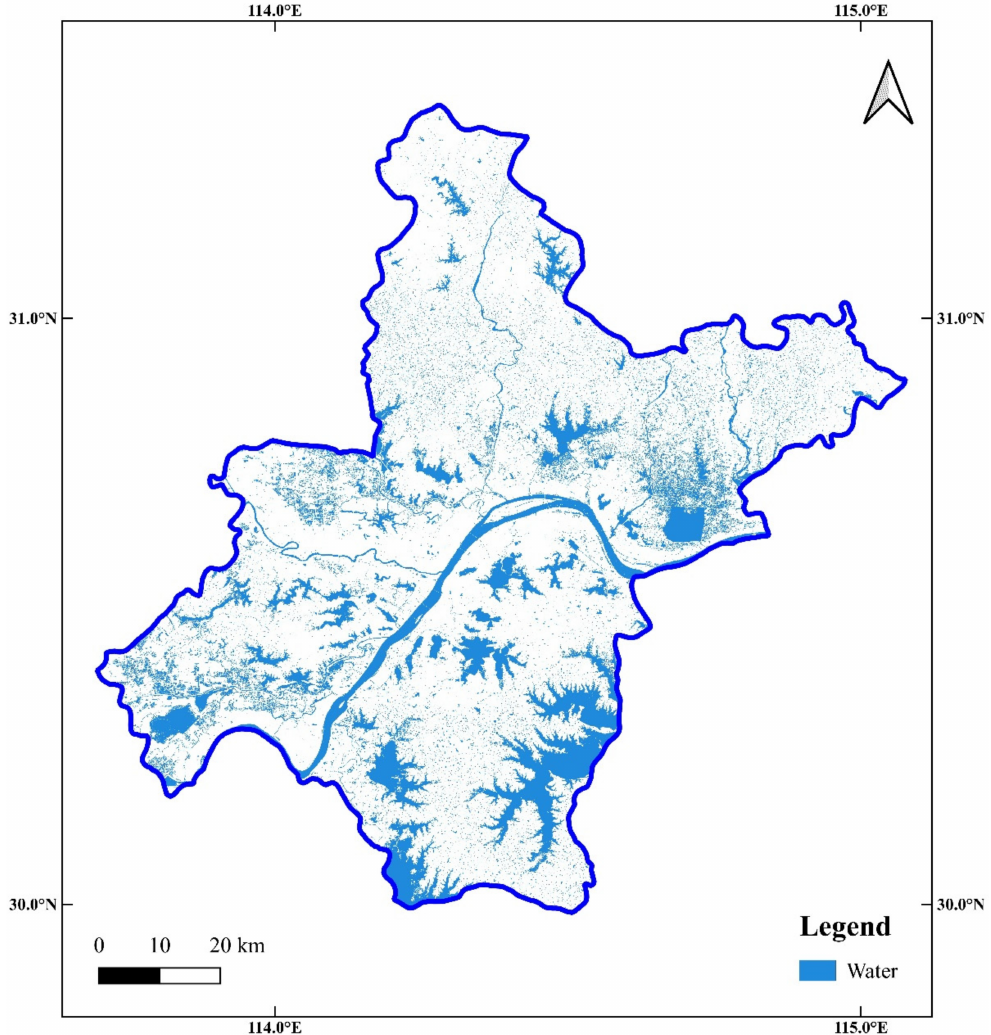
Figure 13. Land surface water map of Wuhan for 2020